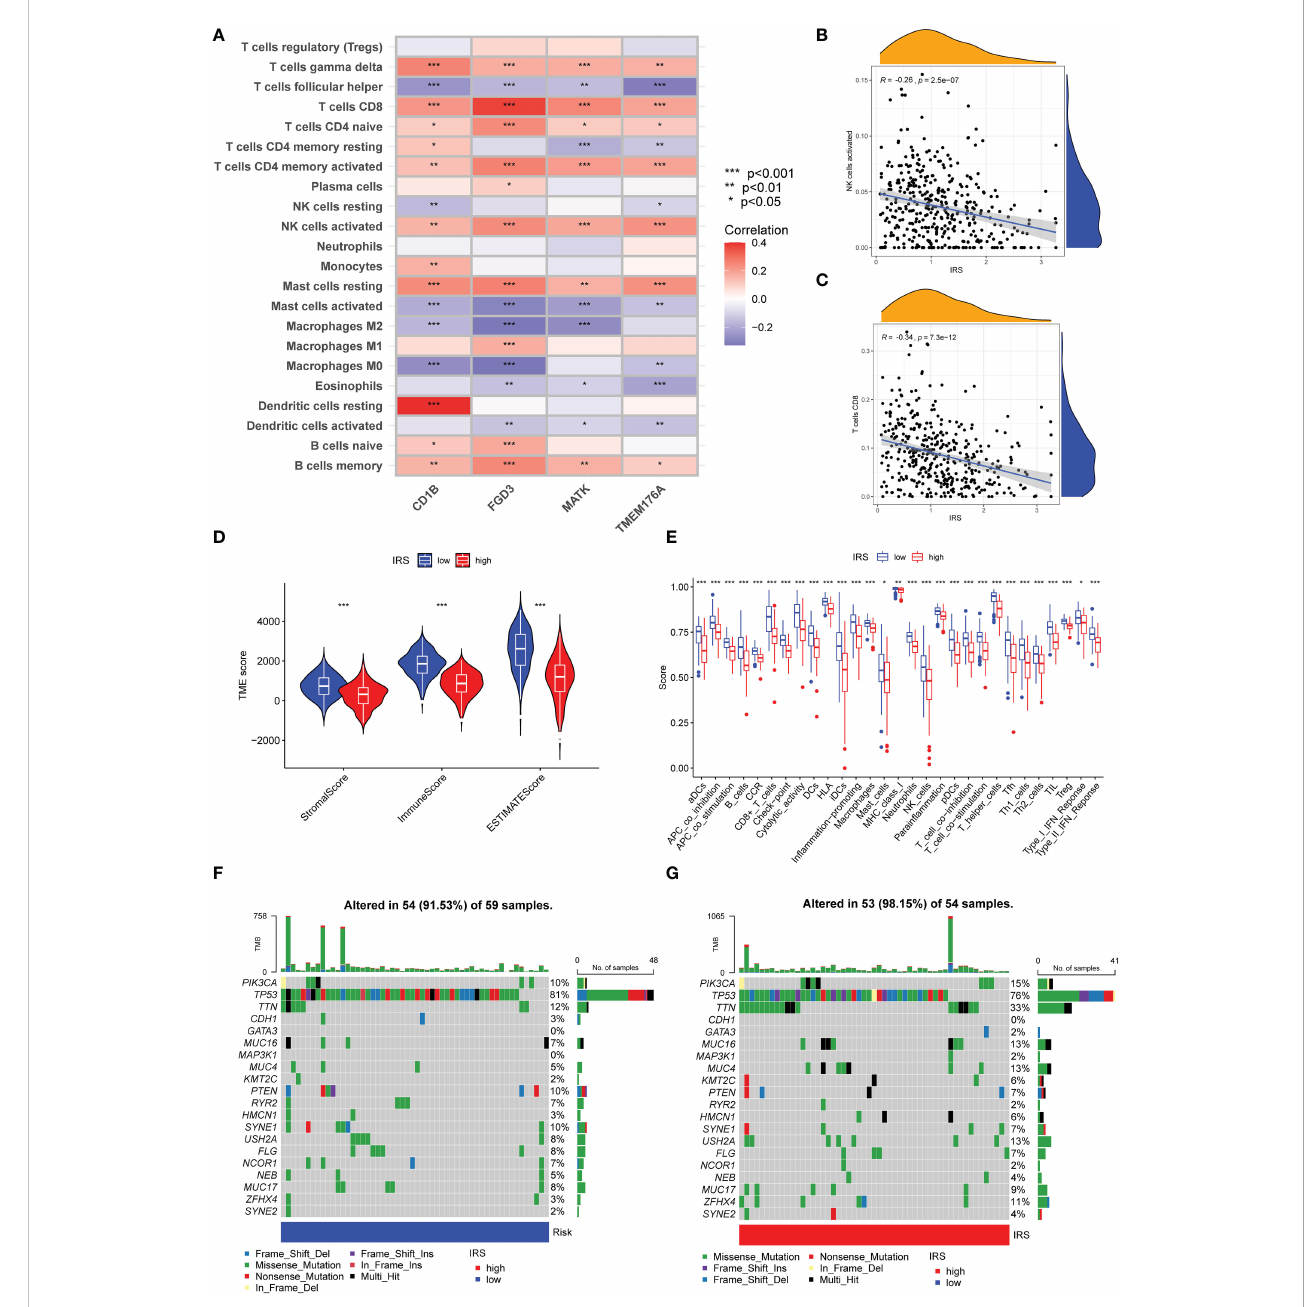
FIGURE 6 Immune Characteristics and genomic features of ICGs-related riskscore model. (A) Heatmap depicting the correlations between the expression of FGD3, TMEM176A, CD1B, MATK and 22 immune in fi ltration cells. (B) Correlation analysis between IRS and the level of activated NK cells in fi ltration. (C) Correlation analysis between IRS and the level of CD8 T cells in fi ltration. (D) Following the ESTIMATE algorithm, the level of stromal, immune, and ESTIMATE scores in different IRS groups. (E) Immune function analysis in different IRS groups. (F , G) The waterfall plot of showed the somatic mutation rate in low IRS and high IRS group. Each column indicated an individual sample. The upper barplot was the tumor mutation burden for an individual sample. The right histogram generalized the percentage of each variant type. The number on the right indicated the mutation frequency for each